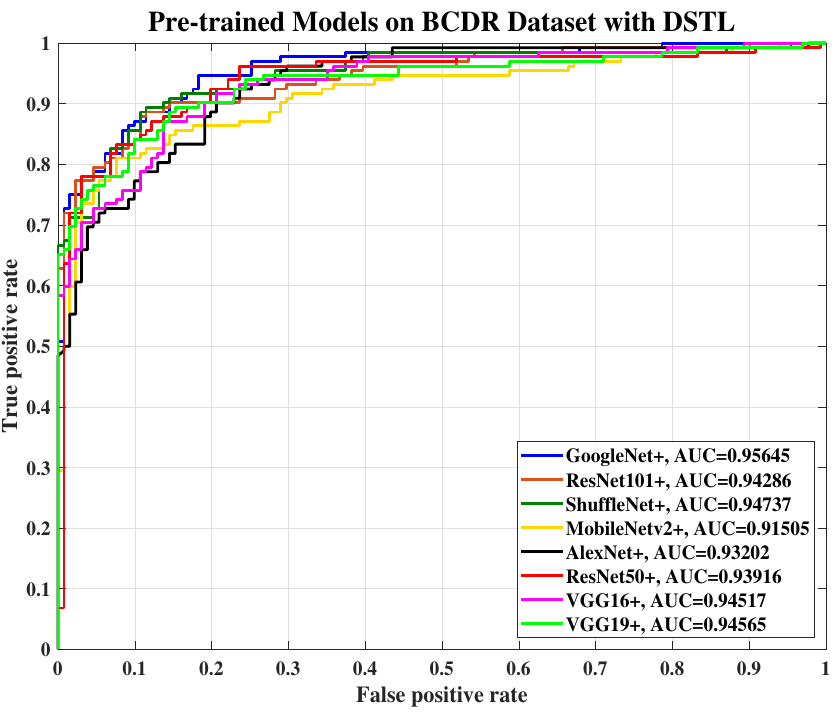
Figure 10. The ROC curve of various pre-trained models with DSTL for breast cancer classification using the BCDR dataset. Table 7. Comparison of various pre-trained models performance using the CBIS-DDSM dataset.